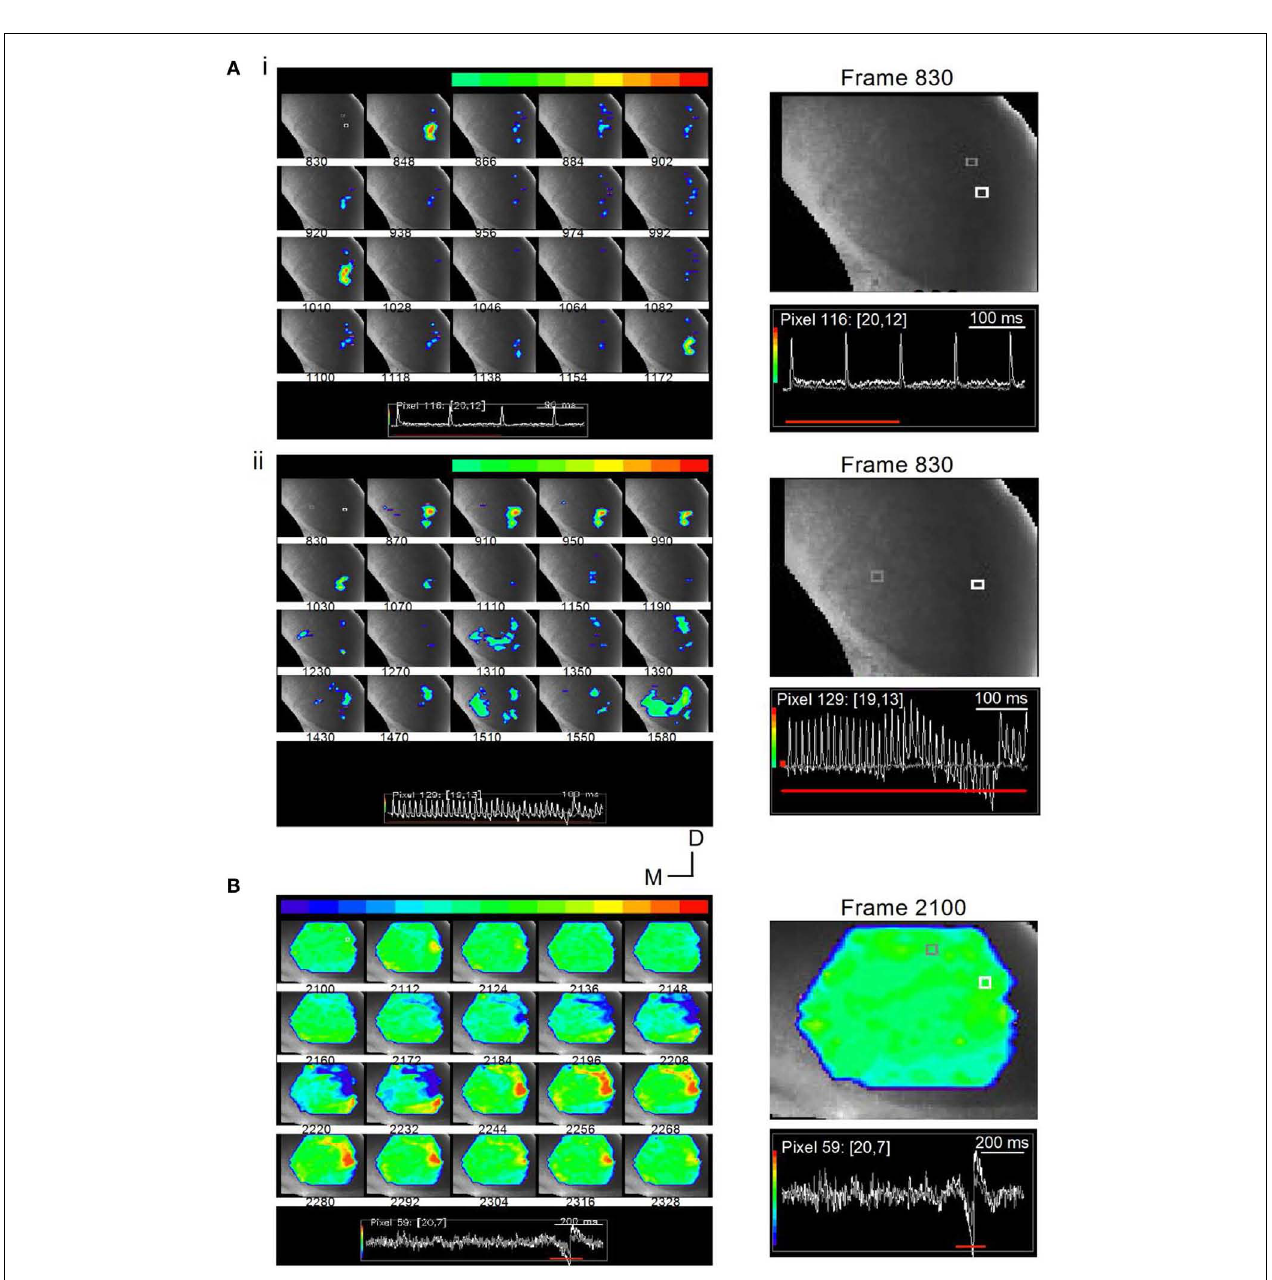
seen in the early frames (870–1070) is lost during the later part of the train (frames 1310–1590). Inset: Color range is chosen to highlight the depolarizing response. Instances of hyperpolarization, e.g., activity below baseline seen toward the end of the train, are therefore omitted from the total response; Right panel, Expanded image of the first frame, 830, with inset traces of responses in white and gray pixels. (B) Time lapse images of responses in a transverse IC slice (rat; P25) to a 1-s long train at 40Hz. Shock strength 0.15mA. Frames are 7.2ms apart. Response region (frames 2100-2328) corresponds to the inhibitory and excitatory motifs of the rebound region only (inset, red line). Color scale is adjusted so that the baseline is set to green to allow for inhibitory responses to appear toward the blue regions. Frame 2112 shows a small localized depolarizing response.This frame precedes the onset of inhibition (frame 2148) by 22ms. Directional scale bar applies to (A,B) . Right panel, Expanded image of the first frame, 2100, with inset traces of responses in white and gray